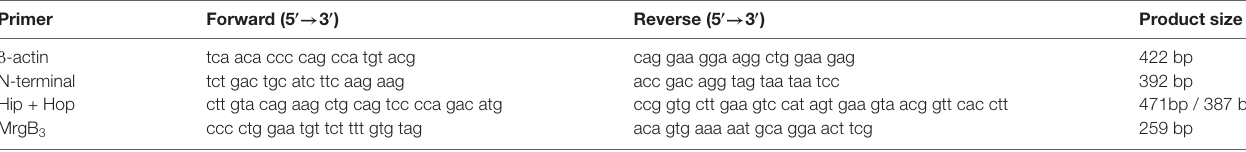
TABLE 1 | Primers designed for detection of the housekeeping gene β -actin, the N-terminal part and the hip-hop variants of the PAC 1 -receptor and the MrgB 3 -receptor. Primer Forward (5 (cid:48) → 3 (cid:48) ) Reverse (5 (cid:48) → 3 (cid:48)